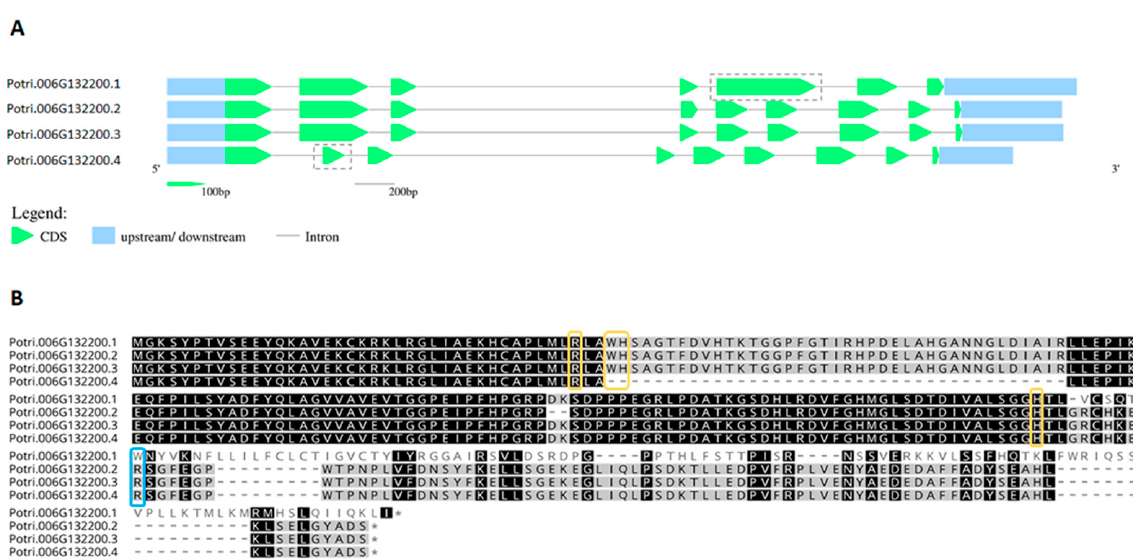
Figure 4. Alternative splicing favors the production of APX or hybrid proteins in Populus trichocarpa . ( A ). The gene Potri.006G132200 encodes four transcripts, two of which differ in the size of the second or fifth exons, indicated in the transcripts’ diagrams. ( B ). The retention of the truncated version of the second exon in Potri.006G132200.4 (PAC ID 27006574) causes the loss of two catalytic residues, which are essential for peroxidase activity (Trp41 and His42). In Potri.006G132200.1 (PAC ID 27006571), the alternative splicing produces a APX devoid of ascorbate binding site, in which Arg172 is replaced by a tryptophan. Ascorbate binding arginine is indicated in blue, and catalytic residues in yellow.